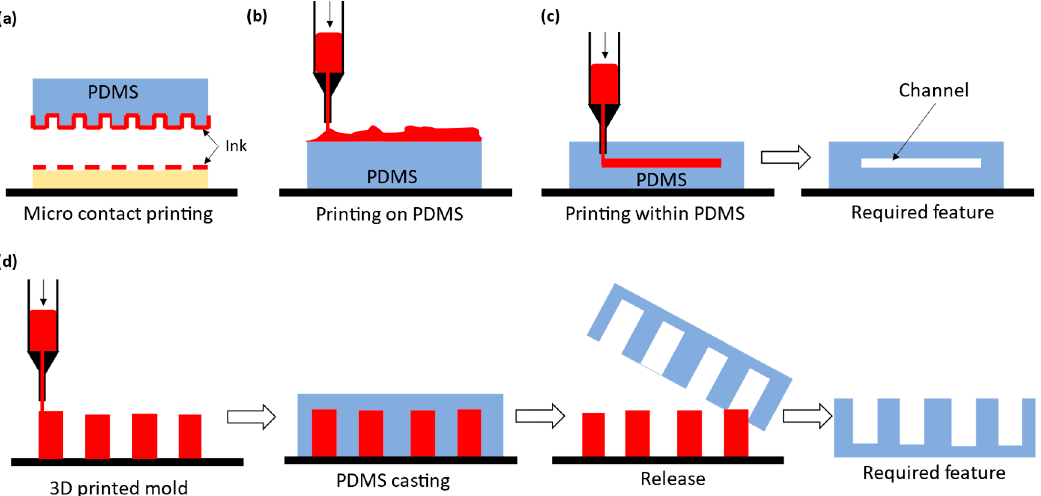
Figure 1. The classification of the indirect PDMS printing techniques. ( a ) Surface patterning technique, commonly known as microcontact printing, using PDMS as a stamp mold for transferring the ink pattern, ( b ) printing on PDMS, ( c ) printing within PDMS and subsequent selective removal of the printed part giving the required feature, and ( d ) printed mold PDMS.